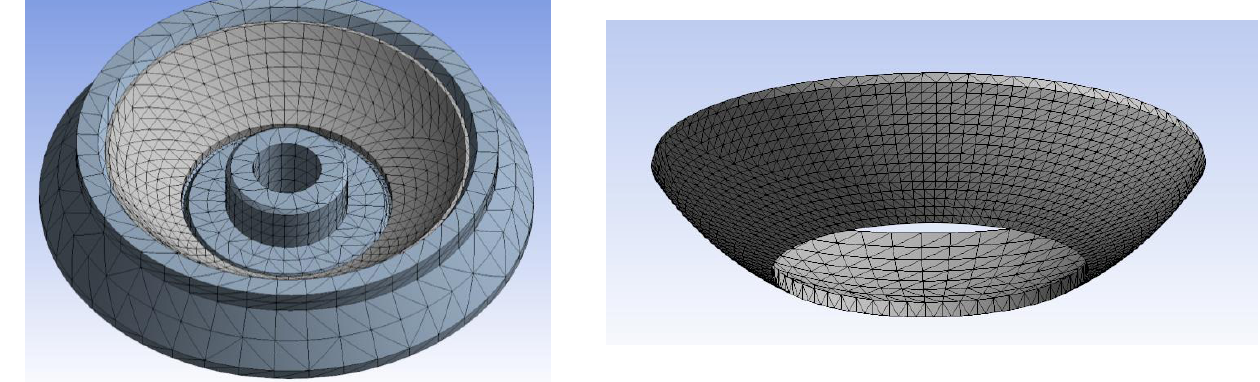
Figure 2. Mesh of the FEM model of centre bowl with friction liner.